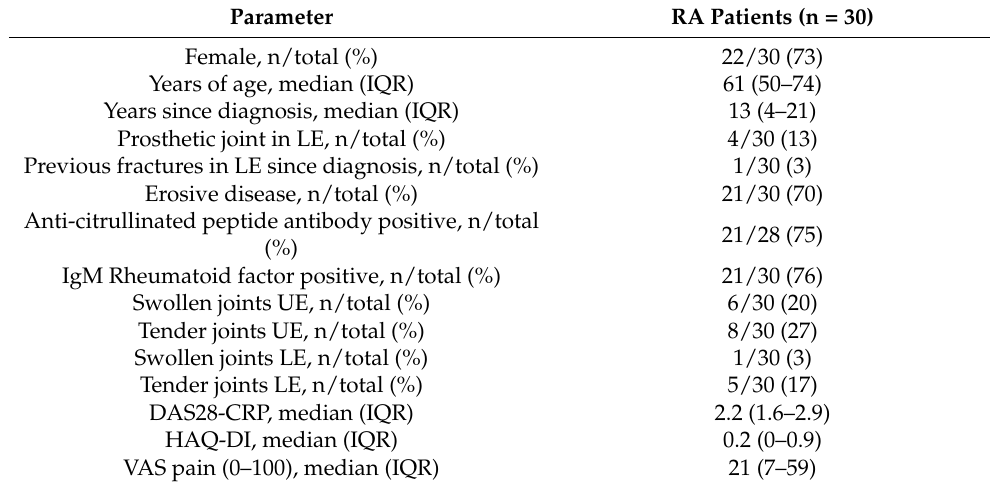
Table 1. Demographics and laboratory and clinical characteristics of patients with rheumatoid arthritis.